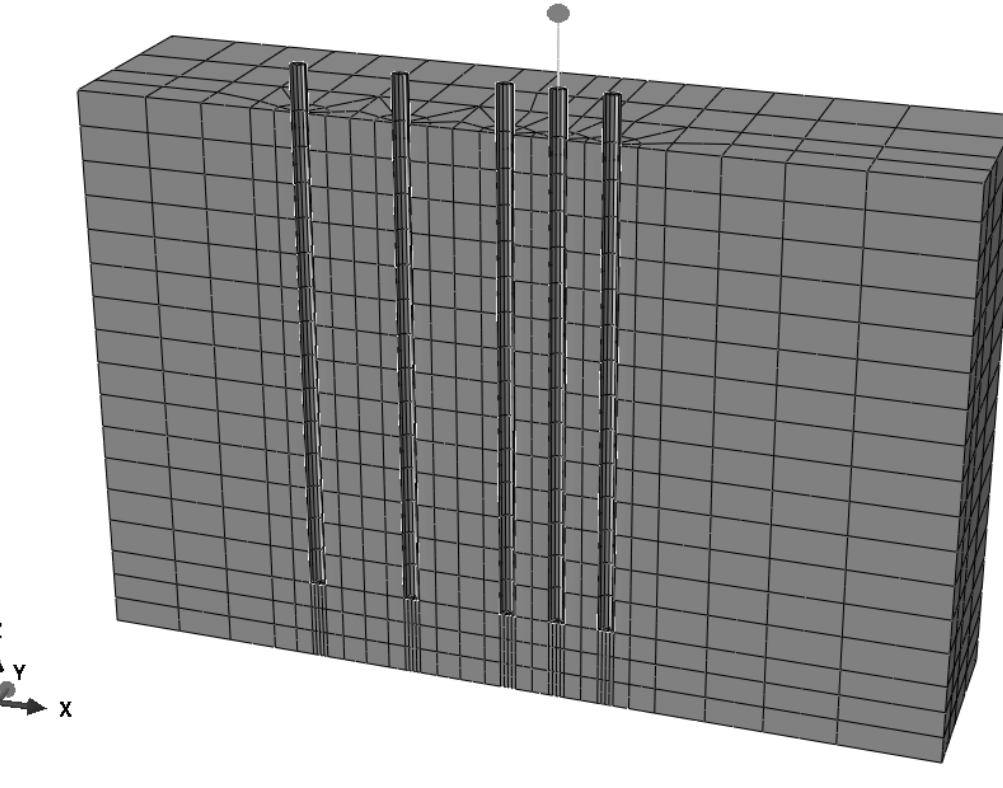
Figure 2: Mesh discretisation used in the 3D finite element